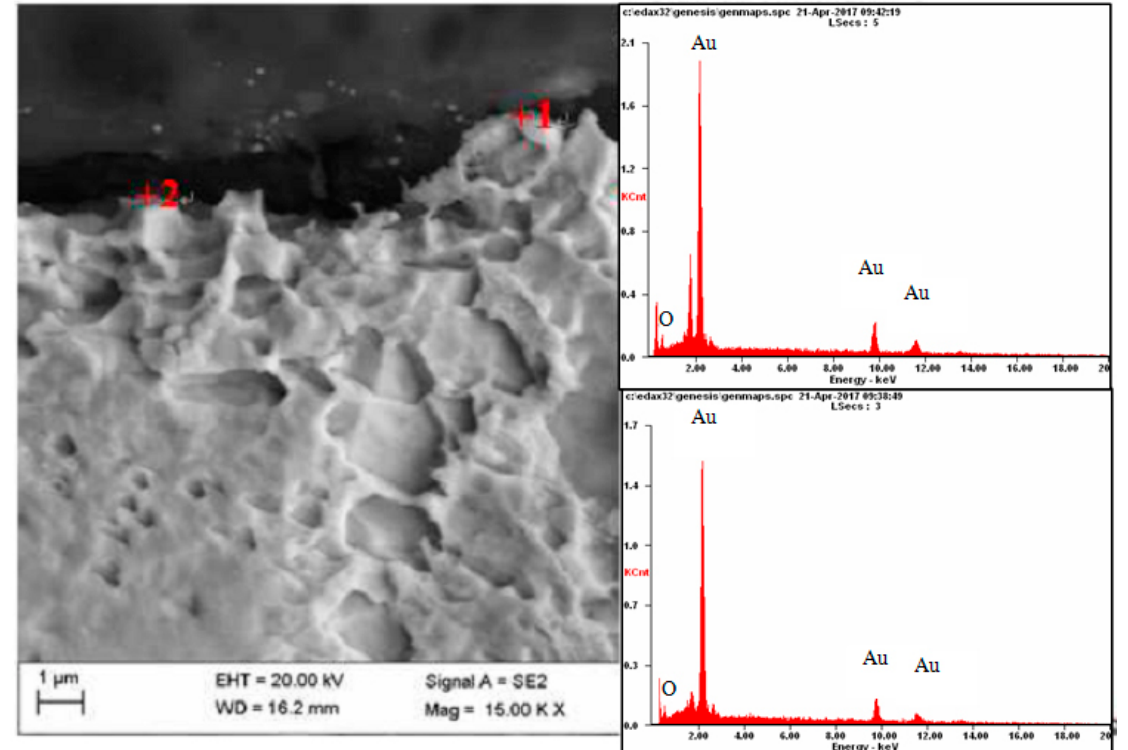
Figure 10. Surface of gold electrode.